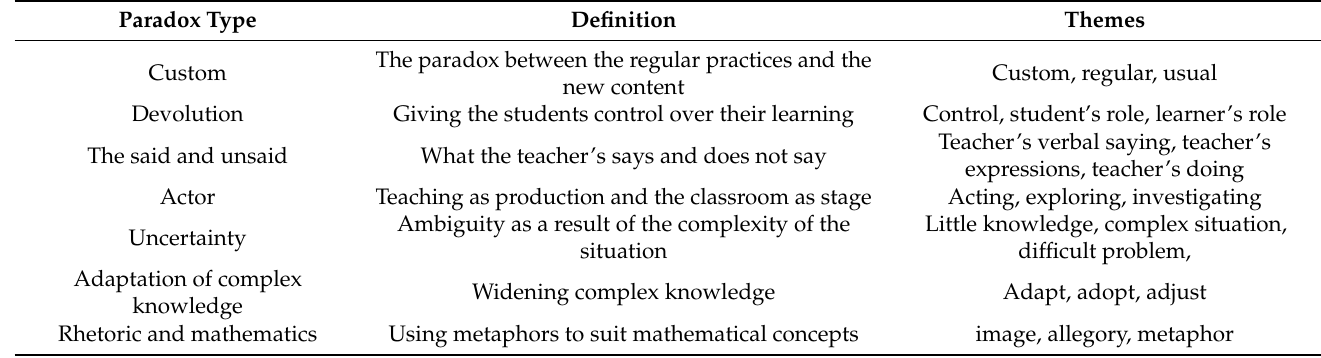
Table 2. Categories of didactical situation paradoxes, their definition, and their themes.